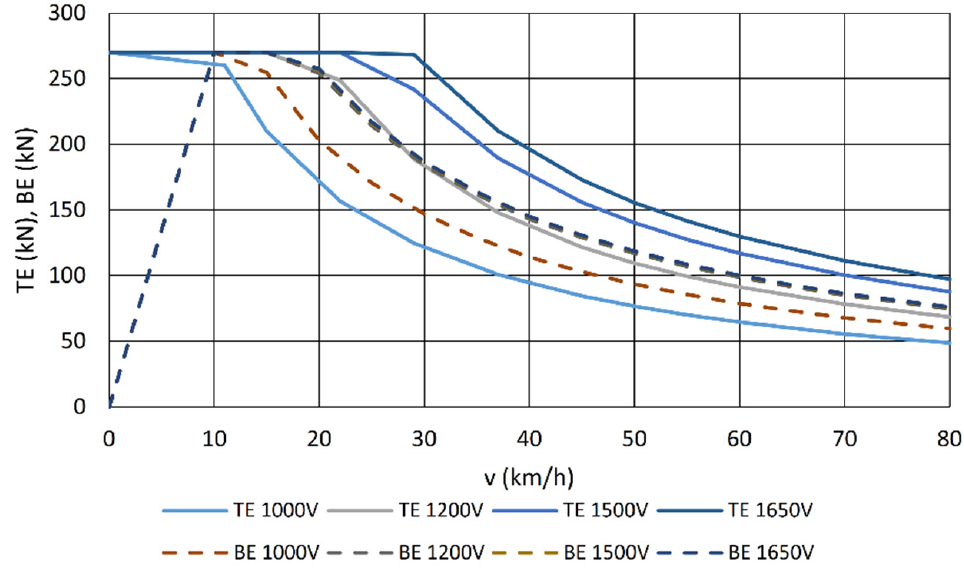
Figure 10. Train tractive effort and braking effort as a function of velocity.